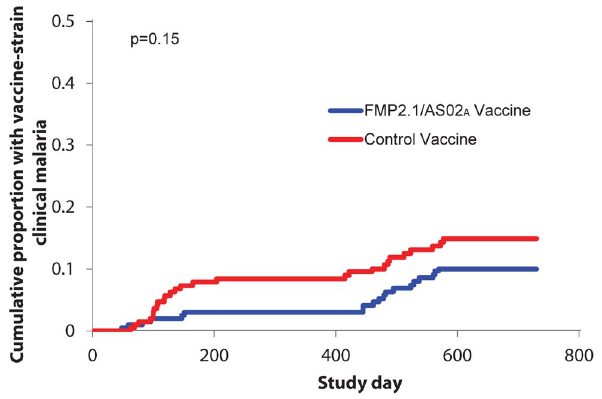
Figure 4. Vaccine efficacy against first episode of clinical malaria with apical membrane antigen 1 (AMA1) cluster 1 loop (c1L) identical to the vaccine strain 3D7 during the entire follow-up period (study days 0–730), intention-to-treat.